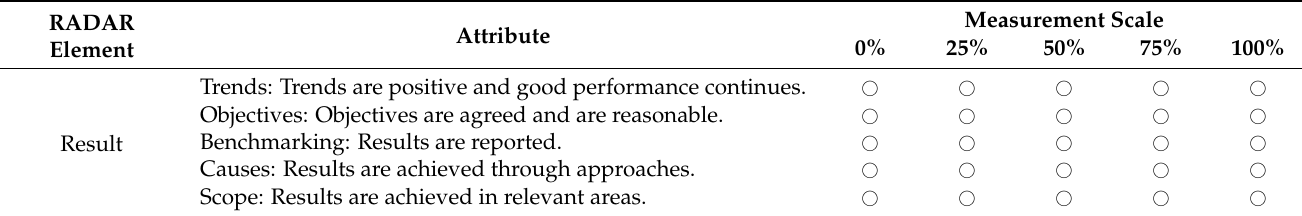
Table A3. RADAR scoring matrix for results.